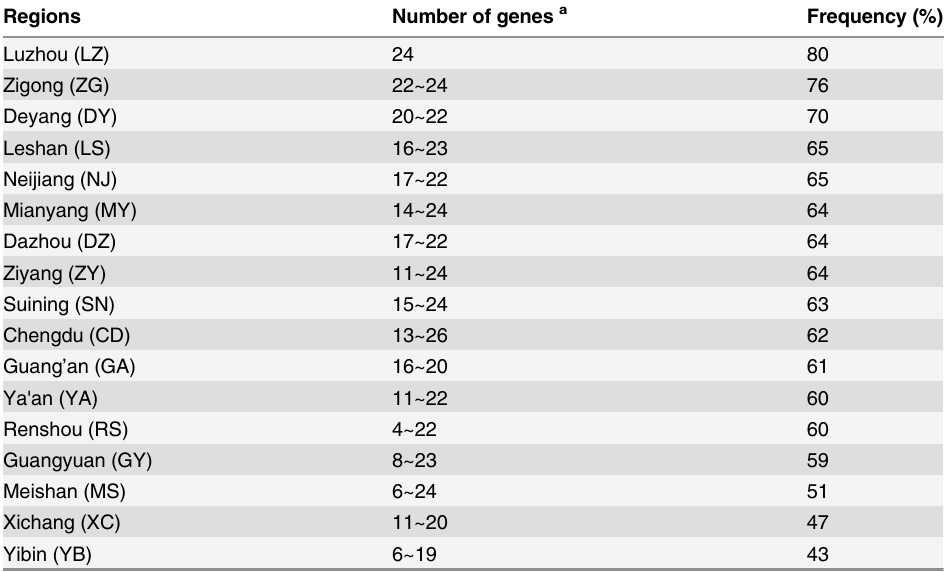
Table 3. The occurrence frequency of the corresponding genes for virulence in Blumeria graminis f. sp. tritici in Sichuan, China. Regions Number of genes a Frequency (%) Luzhou (LZ) 24 80